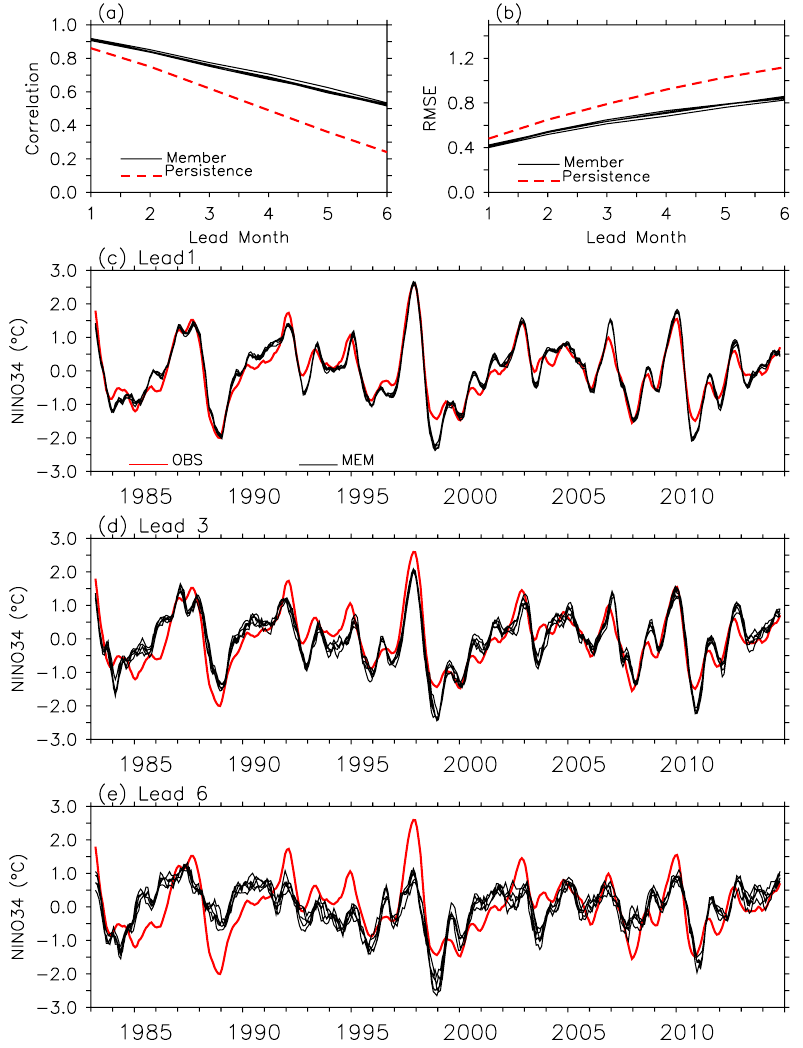
Figure 1. Prediction skill of ENSO. ( a ) Anomaly temporal correlation coefficient (TCC), ( b ) root mean square error (RMSE) between observed and predicted Niño 3.4 indices from 1- to 6-month lead times, and time series of Niño 3.4 index from observations (red line) and forecasts (black lines) at ( c ) 1-month, ( d ) 3-month, and ( e ) 6-month lead times. In ( a , b ), TCCs and RMSEs of persistence and individual member predictions are indicated by red dashed lines and black solid lines, respectively. In ( c – e ), for a clear comparison, the 3-month running mean is applied to the Niño 3.4 index before